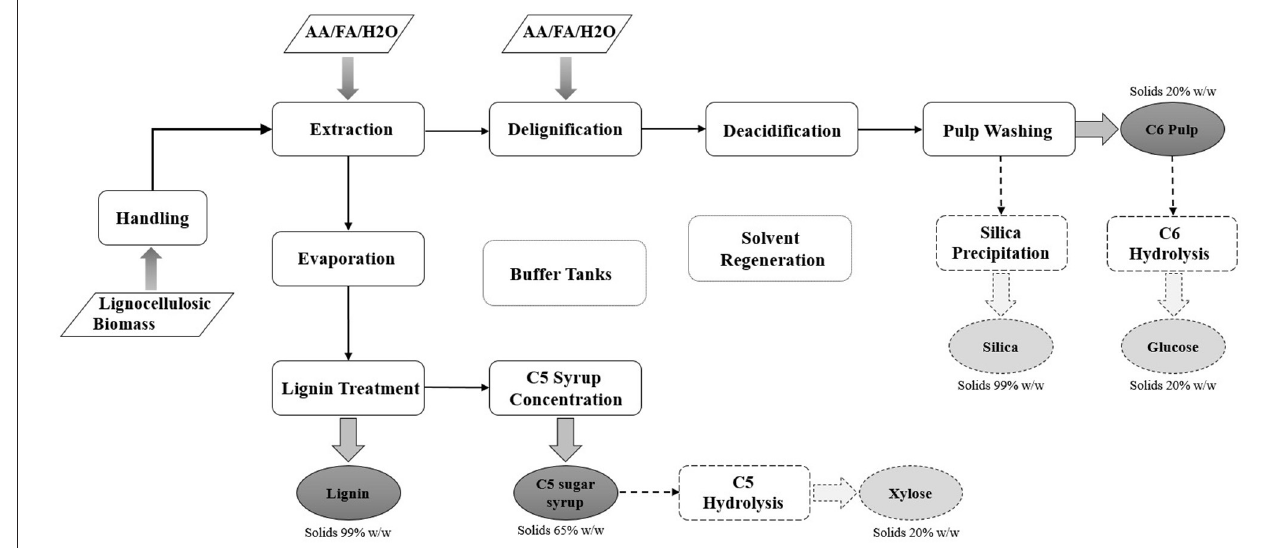
FIGURE 2 | BFD of CIMV